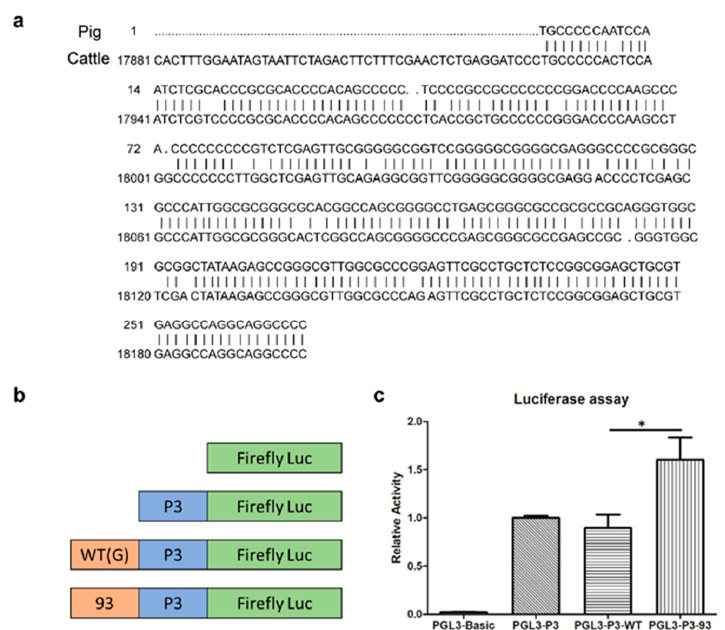
Figure 3. Analysis of the effect of ZBED6-binding site knockout on IGF2 P3 activity in murine C2C12 cells, by dual-luciferase reporter assay: ( a ) Identification of the bovine IGF2 P3 promoter using homologous alignment. The upper bases of each line are the porcine IGF2 P3 sequence; the lower bases of each line are the bovine IGF2 sequence. ( b ) Design of the four experimental plasmids. The orange rectangle refers to the 578 bp fragment containing the ZBED6-binding site, the blue rectangle refers to the IGF2 P3 promoter, and the green rectangle refers to the luciferase gene. ( c ) Relative luciferase expression in cells transfected with different plasmids. Data are presented as the mean ± SD ( n = 3); * indicates p ≤ 0.05.